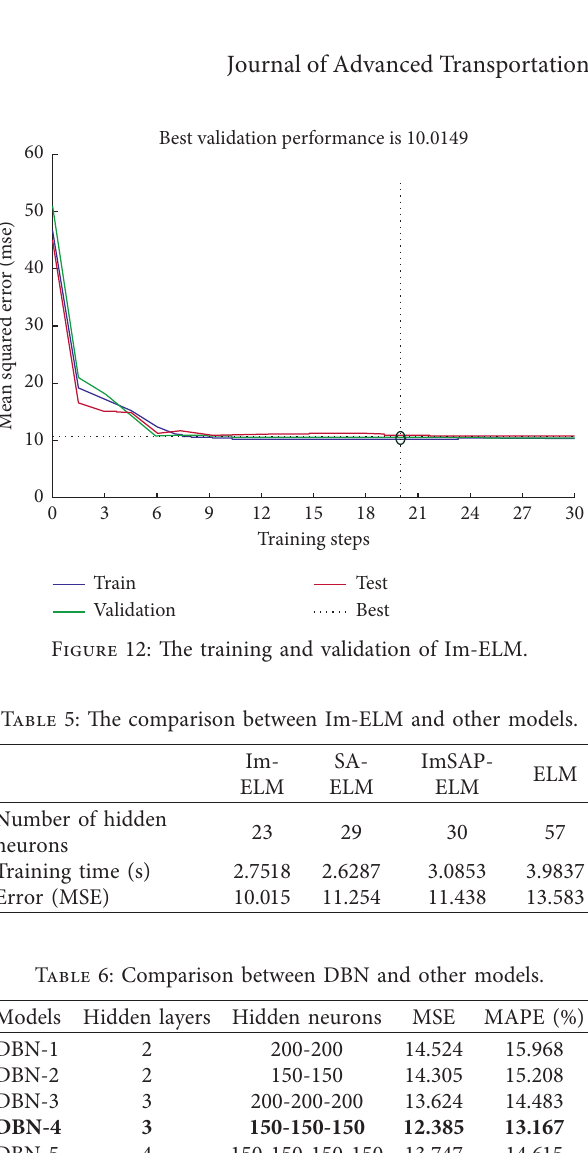
Figure 11: The variation curve of training error.